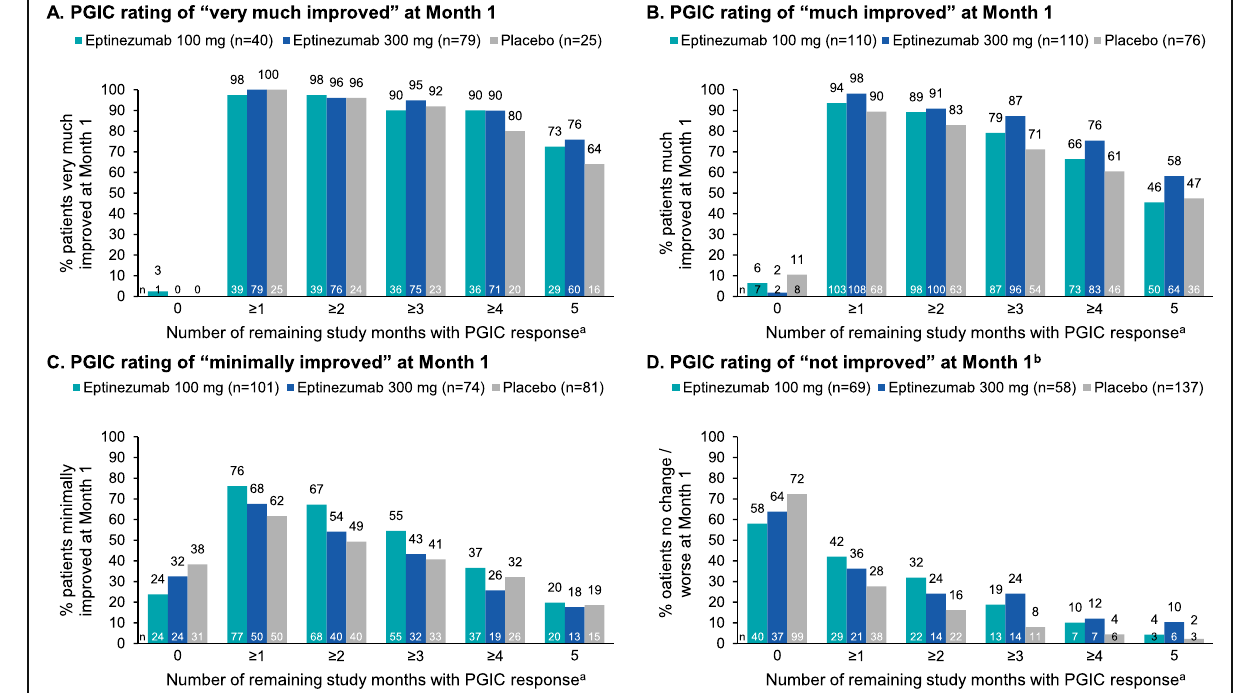
Fig. 5 Frequency of PGIC response a according to PGIC rating at Month 1: ( A ) very much improved, ( B ) much improved, ( C ) minimally improved, ( D )